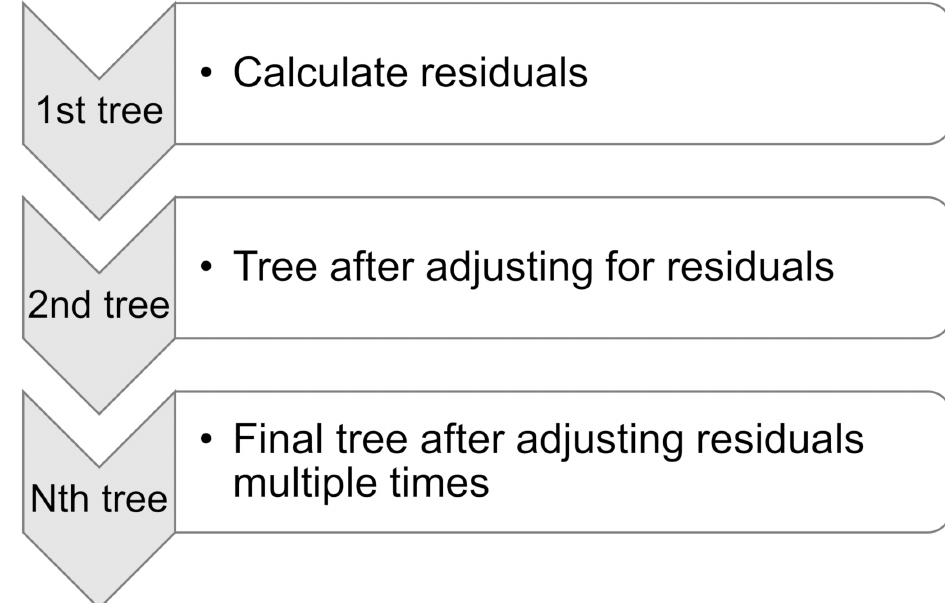
Figure 4. Schematic representation of gradient boosting technique